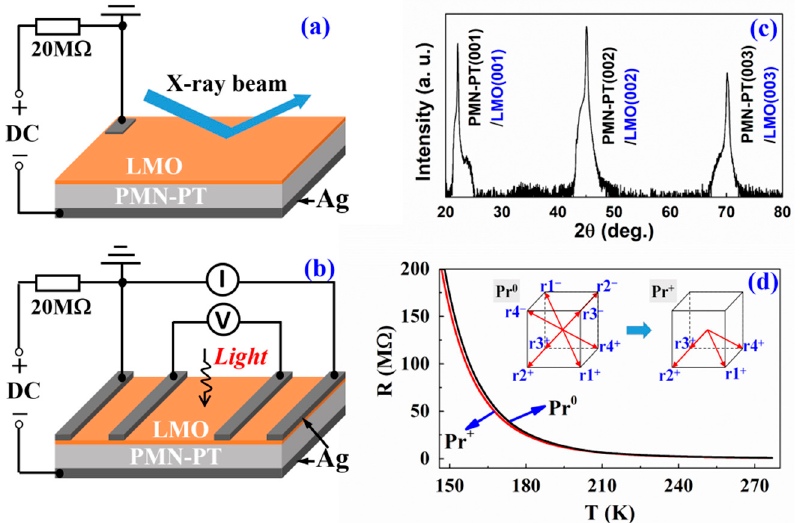
Figure 1. Schematic illustrations of the experimental setups for in situ measurements of ( a ) out-of- plane strain of the LMO/PMN-PT heterostructure and ( b ) the LMO film resistance, respectively. ( c ) XRD θ –2 θ scan pattern of the LMO/PMN-PT heterostructure. ( d ) The temperature dependence of the LMO film resistance when the PMN-PT was nonpolarized Pr 0 and positively polarized Pr + . The inset shows the polarization vectors of the PMN-PT four structural domains in Pr 0 state and Pr + state.